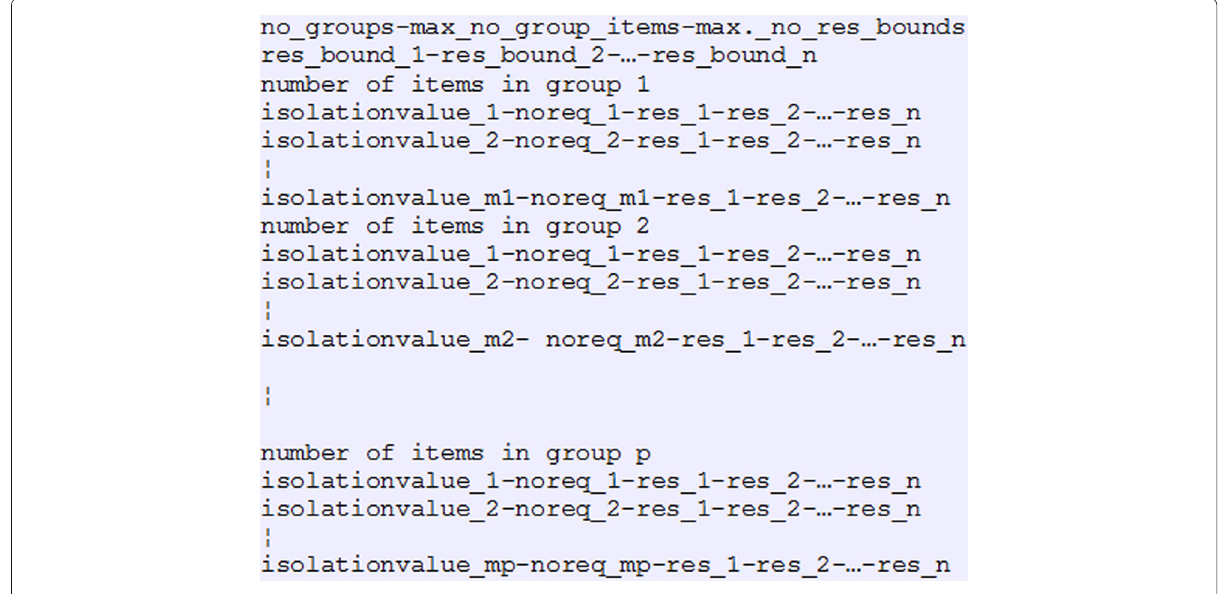
Fig. 7 Format of the MMKP instance